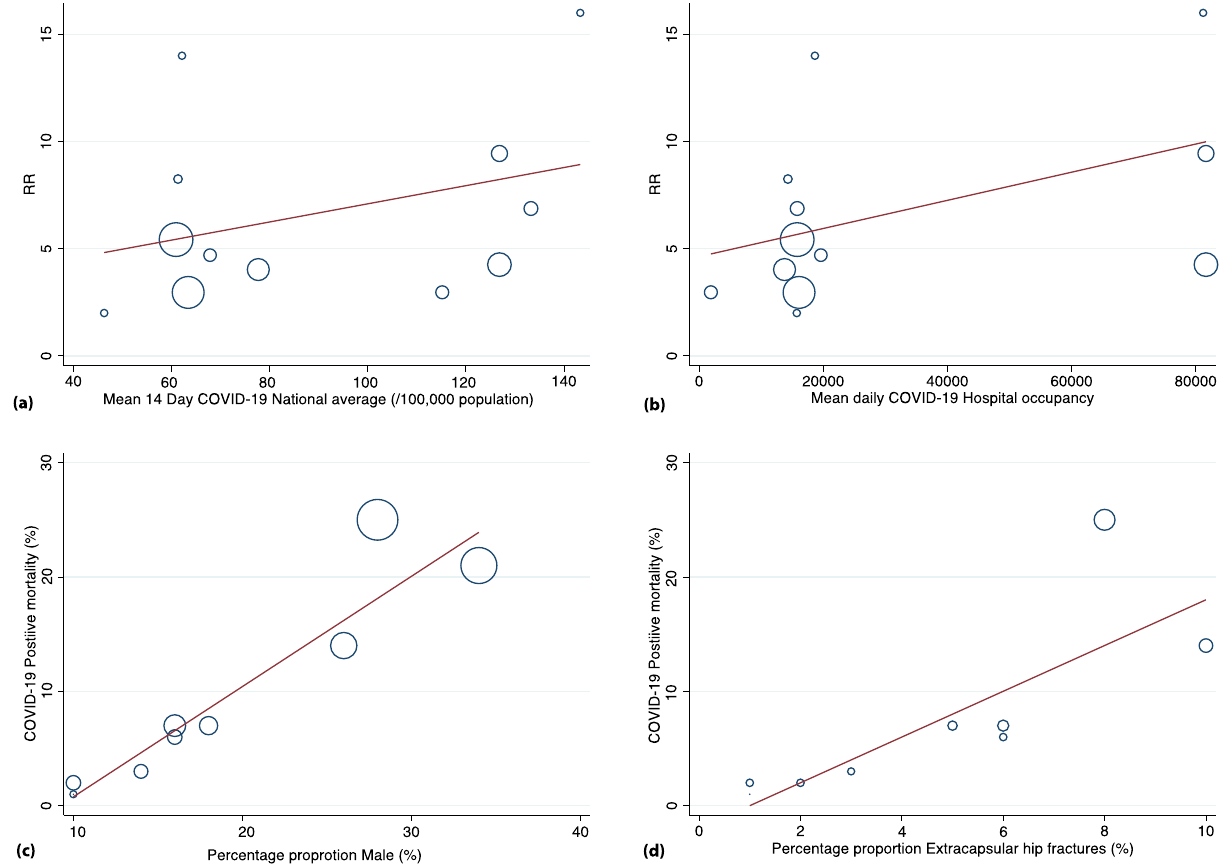
mortality. ( c ) Shows the meta-regression plot on the impact of male proportions on COVID-19 positive hip fracture mortality. ( d ) Shows the meta-regression plot on the impact of proportions of extracapsular hip fractures on COVID-19 positive hip fracture